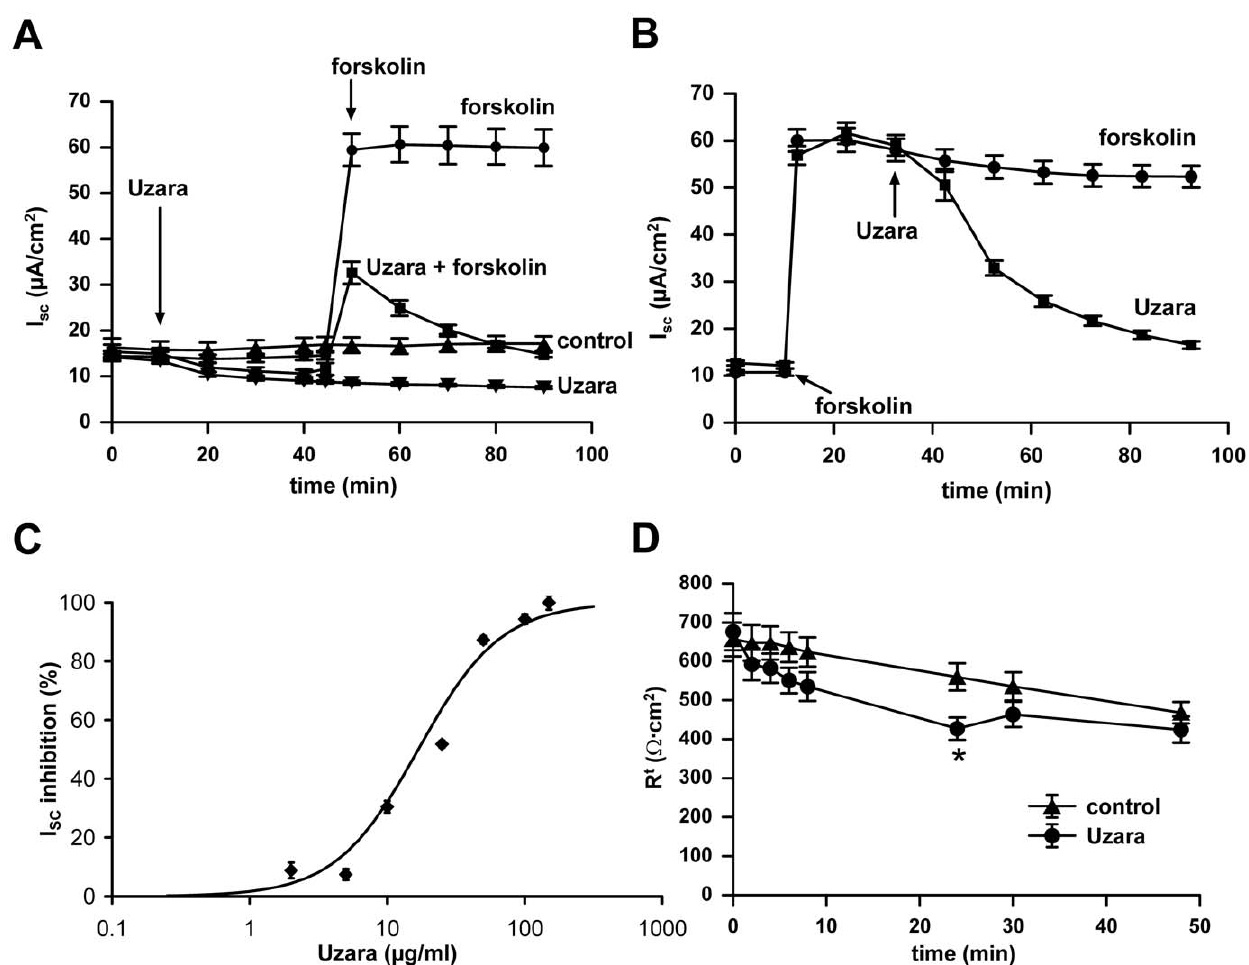
Figure 1. Inhibitory effect of Uzara on the forskolin-induced I SC rise in HT-29/B6 cells. I SC was measured on HT-29/B6 monolayers mounted in Ussing chambers. In A and B, Uzara (50 m g/ml) was added on the basolateral side either 30 minutes prior (A) or 30 minutes after (B) basolateral addition of 10 m M forskolin. In C, different Uzara concentrations were applied basolaterally 30 minutes after forskolin stimulation. The percentage of the inhibitory activity of Uzara to the forskolin-induced I SC rise was calculated after an incubation time of 1 hour. An IC 50 of 17 m g/ml and a Hill coefficient of 1.45 were determined from a Hill plot diagram and used to calculate the continuous line. All values are expressed as mean 6 s.e.m. (n=5-7). D: Transepithelial resistance measurements over 48 hours after application of either ethanol (control: final concentration 0.05%) or 50 m g/ml Uzara (final ethanol concentration 0.054%). With the exception of the resistances 24 hours after the application of uzara, none of the resistance values in the presence of uzara differed significantly from the corresponding control value. (means 6 s.e.m. n=12).